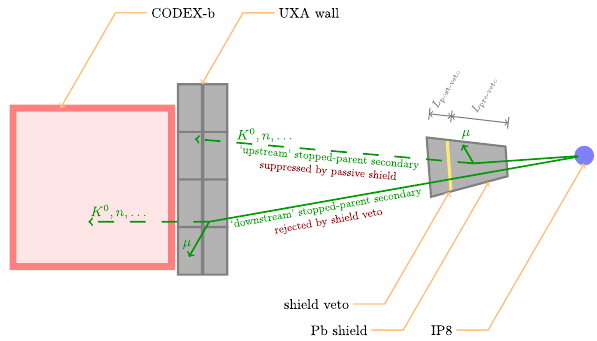
Fig. 21 Cross-section of the shielding configuration of the Pb shield (gray), active shield veto (gold), and concrete UXA wall with respect to IP8 and the detector volume. Also shown are typical topologies for production of upstream and downstream stopped-parent secondaries, which are suppressed by passive shielding or rejected by the active shield veto,